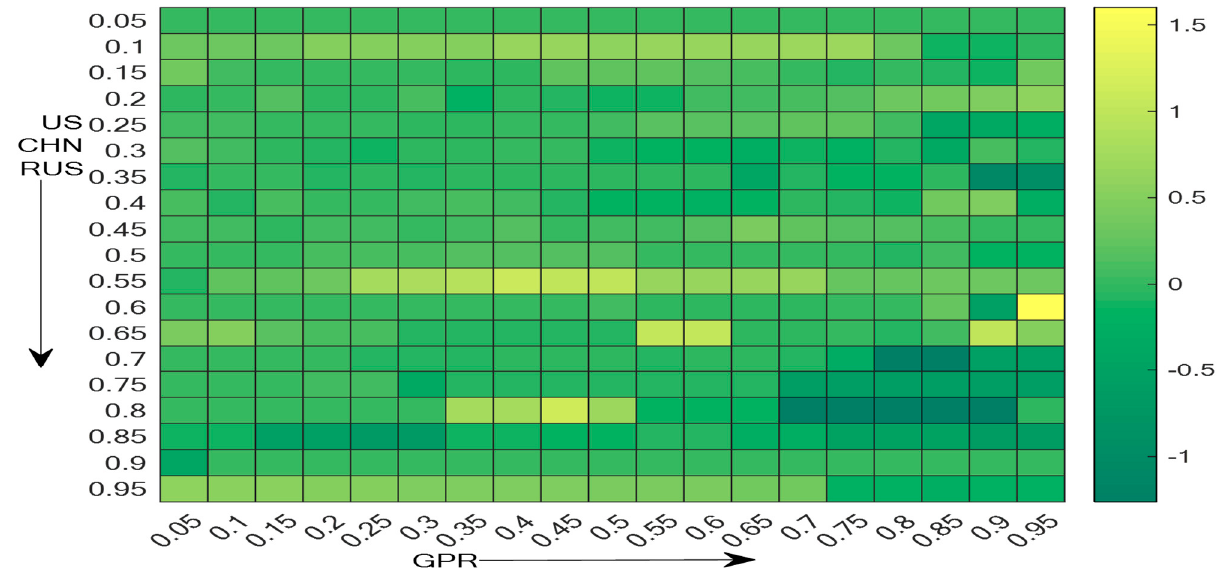
Figure 5. The response of total stock market synchronization to geopolitical risk. Note: The horizontal axis indicates the quantile of GPR, whereas the vertical axis is the quantile of stock market synchronization in ascending order. The right-side color bar indicates the intensity of the response of synchronization to GPR. The dark green and yellow colors indicate negative and positive responses and synchronization to GPR, respectively.